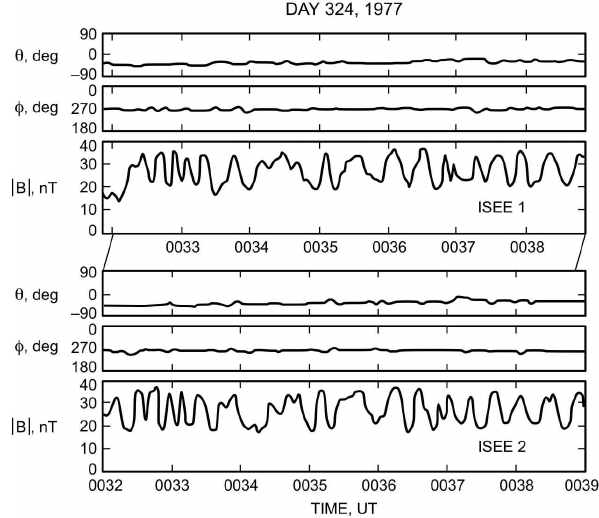
Fig. 12. Mirror mode structures detected by two closely separated spacecraft (ISEE-1 and -2). The magnetosheath flow convects the structures from ISEE-2 to ISEE-1.